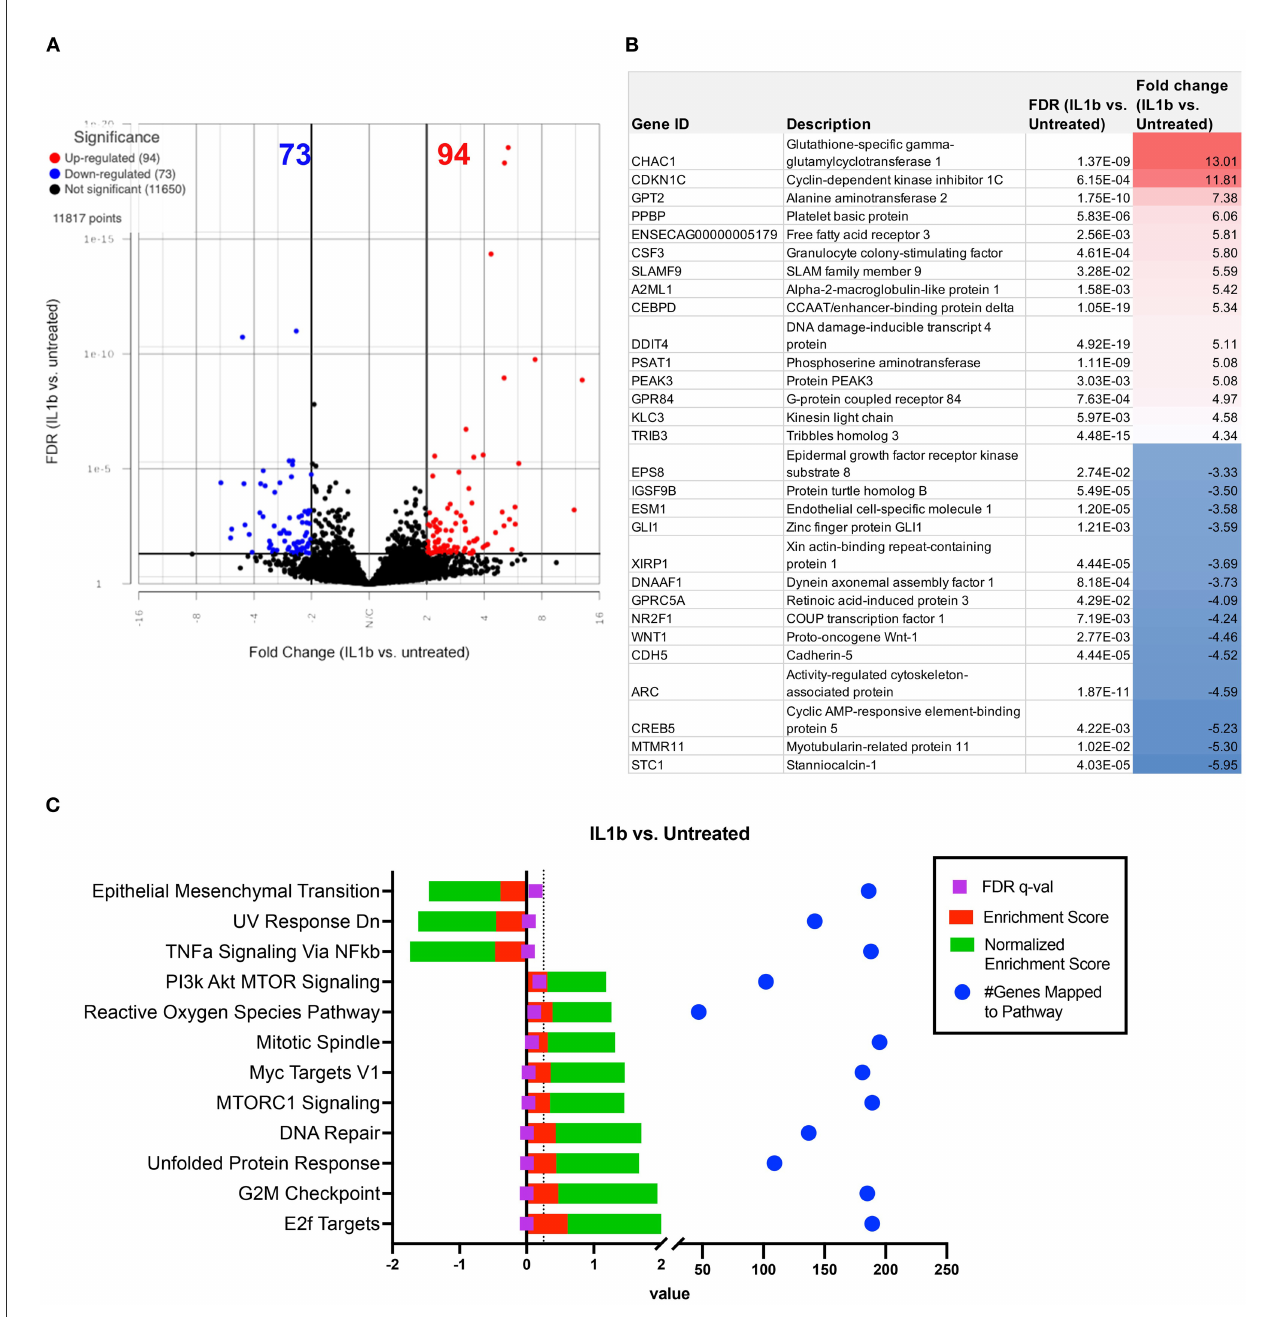
FIGURE4 Differential gene expression and pathway analysis of IL-1ß stimulated macrophages compared to untreated. (A) Volcano plot of IL-1ß treatment vs. untreated. X axis shows fold change and y axis shows FDR adjusted p -value, with significantly upregulated genes shown in red dots and significantly downregulated genes in blue dots. Significance defined as FDR ≤ 0.05 fold change ≥ 2 or ≤ − 2. (B) List of genes, description, FDR value and fold change of top 15 upregulated and downregulated genes in differential analysis results from IL-1ß vs. untreated samples. (C) GSEA (gene set enrichment analysis) results using normalized counts from n = 3 IL-1ß vs. untreated macrophages. FDR p -values shown in purple with dotted line on FDR = 0.25 for significance. Red bars show enrichment score (ES), green bars show Normalized enrichment score. Blue dots show total genes found in pathways. Pathways computed using hallmarks gene sets